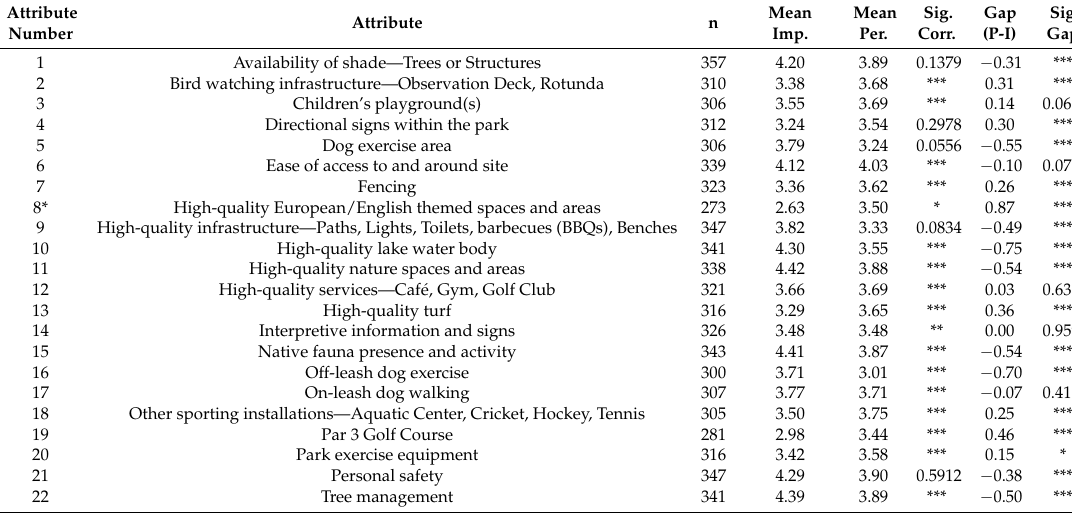
Table 2. The importance of attributes of quality PGI spaces for users of the Lake Claremont site and the performance of those attributes with respect to meeting user expectations (i.e., visitor satisfaction). Attribute numbers relate to the data labels used in the Importance-Performance Analysis (IPA) plots (Figures 2 and